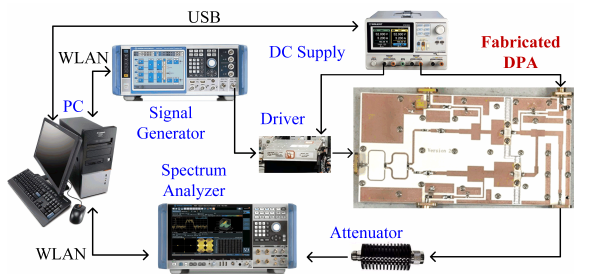
Figure 10. Photograph of the fabricated DPA and its experimental environment.